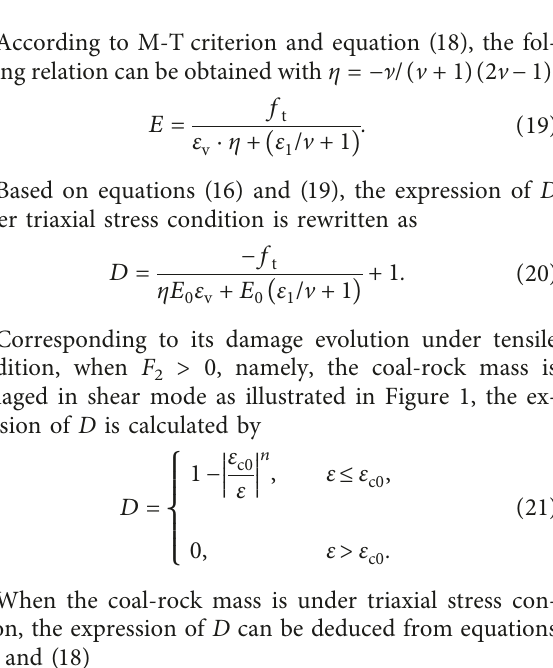
Figure 1: Curves of elastic damage constitutive relations under uniaxial